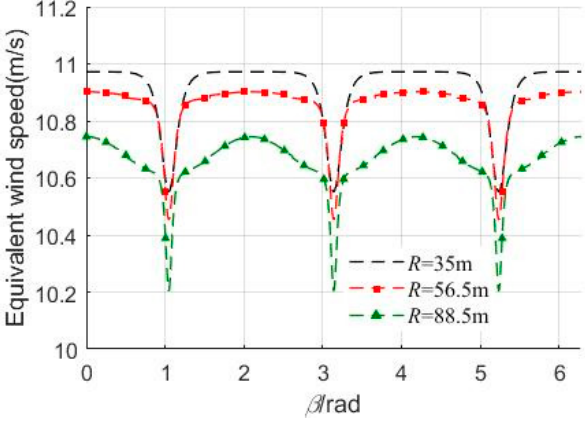
Figure 5. Equivalent wind speed corresponding to different wind turbines.